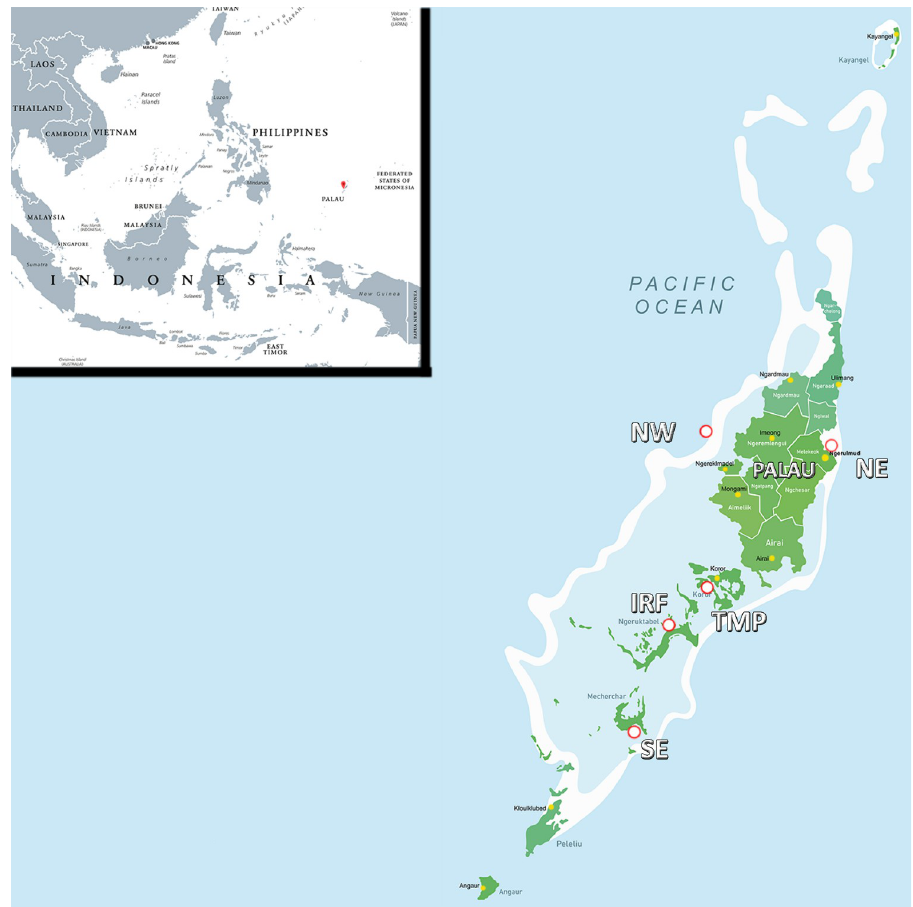
Fig 1. Map of the microplastic sampling sites around the main island Babeldaob and the Southern Rock Island Lagoon in the Palau archipelago.